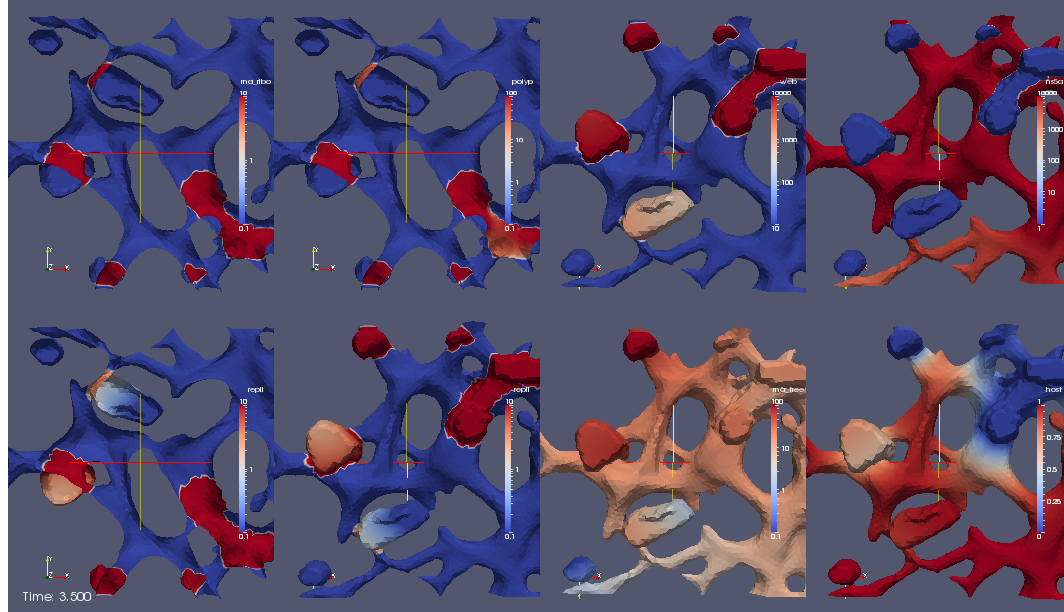
Figure 5. Screenshot of the simulation of the improved surface model as visualized in movie “Video S1—Population Dynamics Inspired sPDE Model Static View” (description cf. Section 3.1, movie attached as Supplemental S1). Each sector depicts one concentration. In part, different perspectives are used. Upper row, from left to right: Ribosomal-bound HCV RNA, polyprotein, web protein, and NS5a. Lower row, also left to right: Replication complex (ER disclosed by means of a cutting plane),